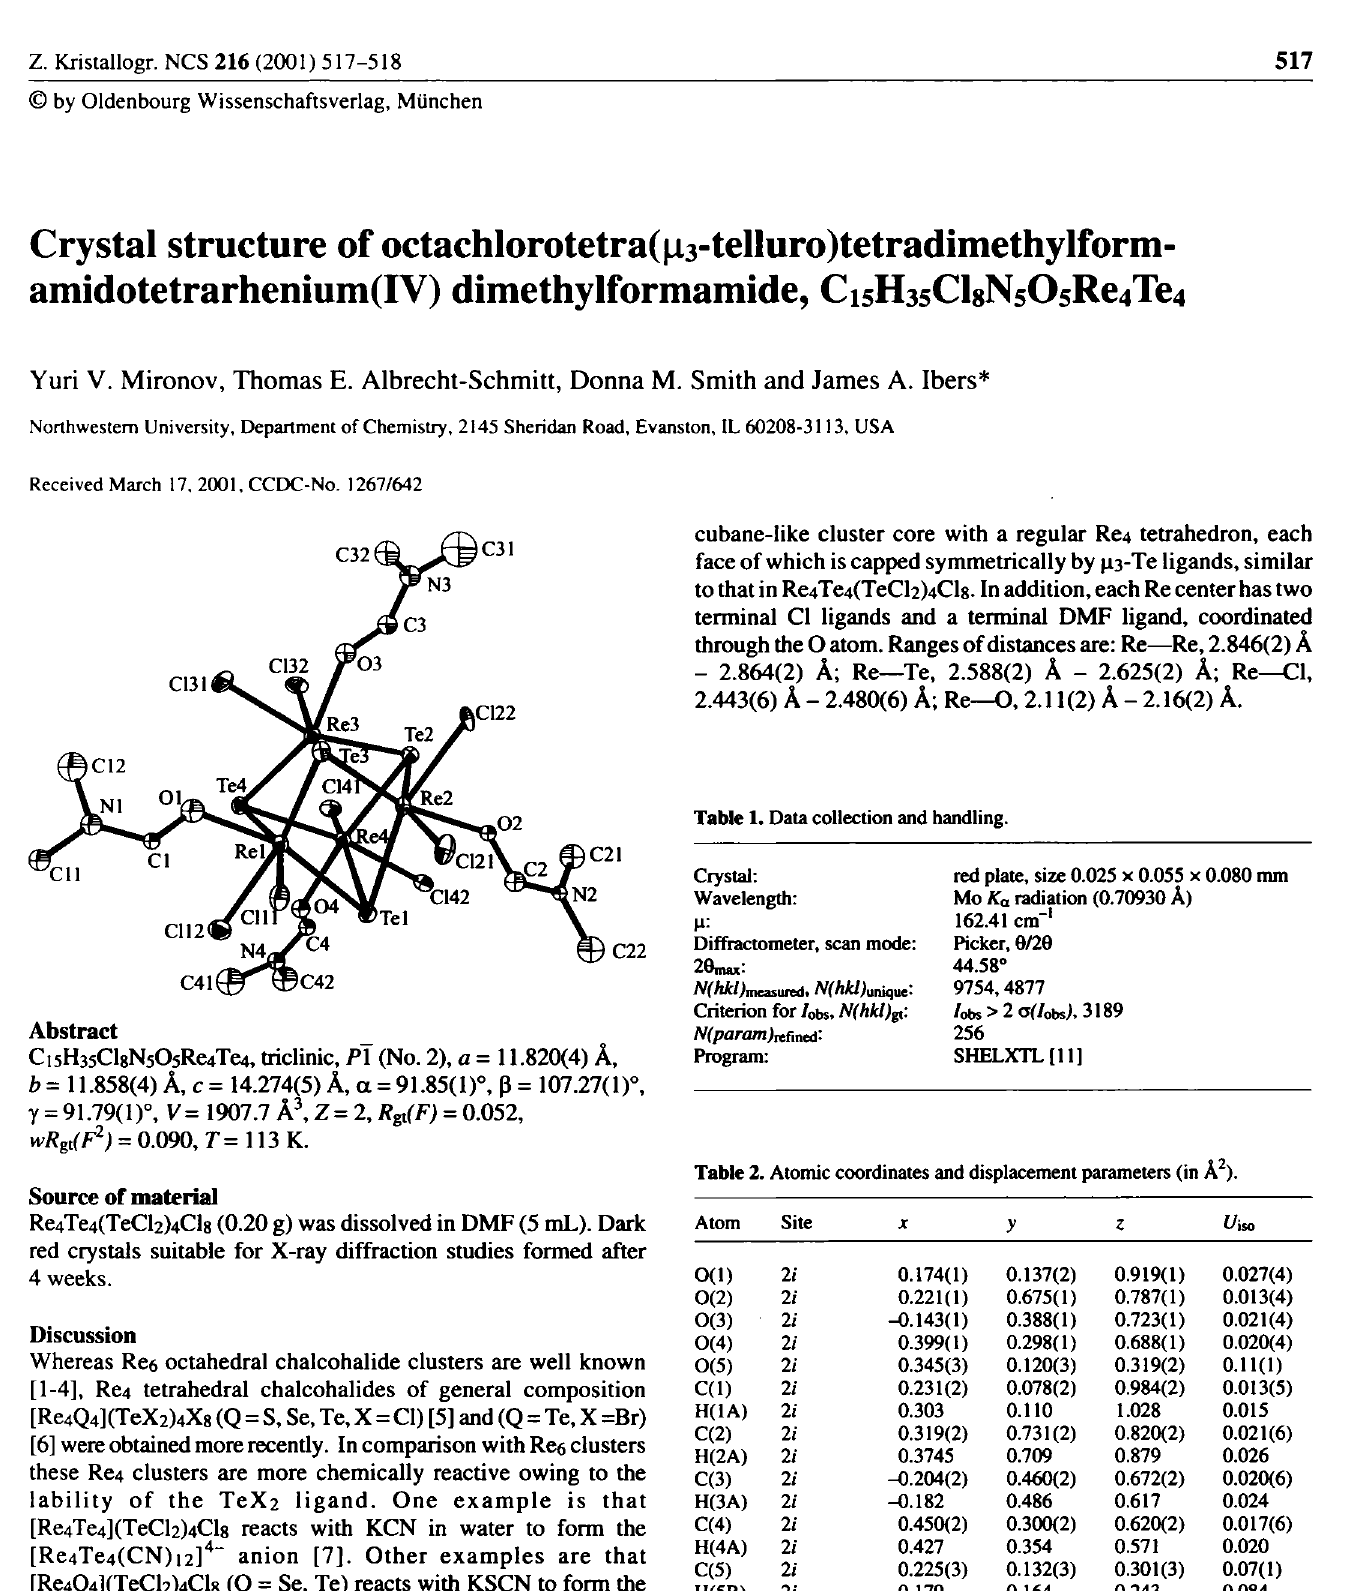
Table 2. Atomic coordinates and displacement parameters (in A 2